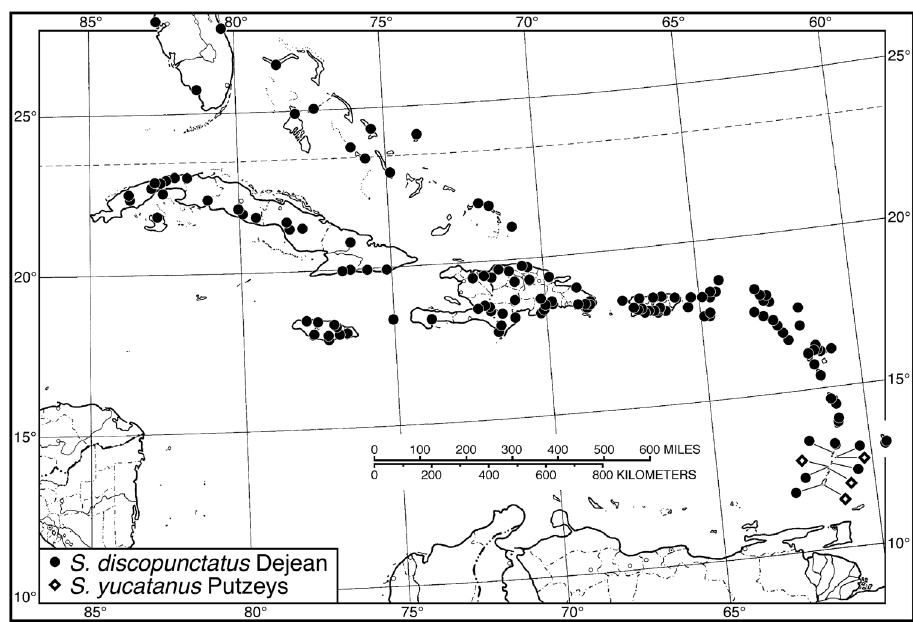
Figure 17. Map of West Indies showing known localities for species of Selenophorus discopunctatus spe- cies